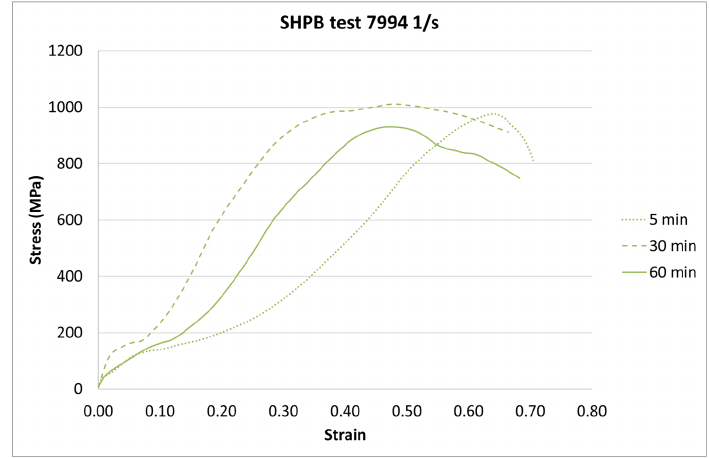
Figure 16. Results of the SHPB test (strain rate of 7994 1/s) of durable resin for curing times of 5, 30, and 60 min for UV and heat exposure.